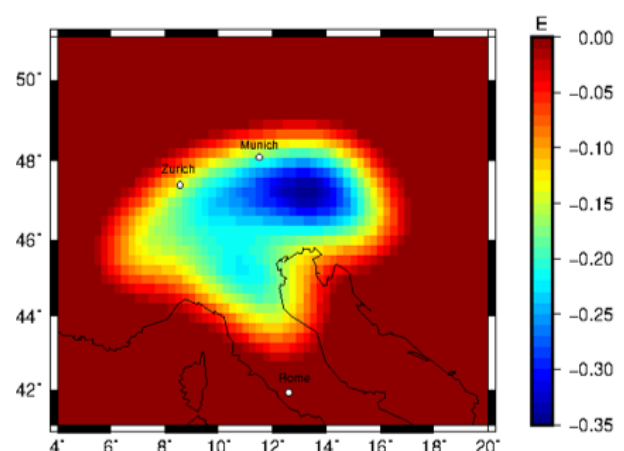
Figure A6. Forward-calculated gravity effect for the gzz component at satellite height of a Proterozoic lithospheric slab segment to a Tecton compositional surrounding mantle for Configuration 2 obtained by calculating the residual between M 8 and M 0 .